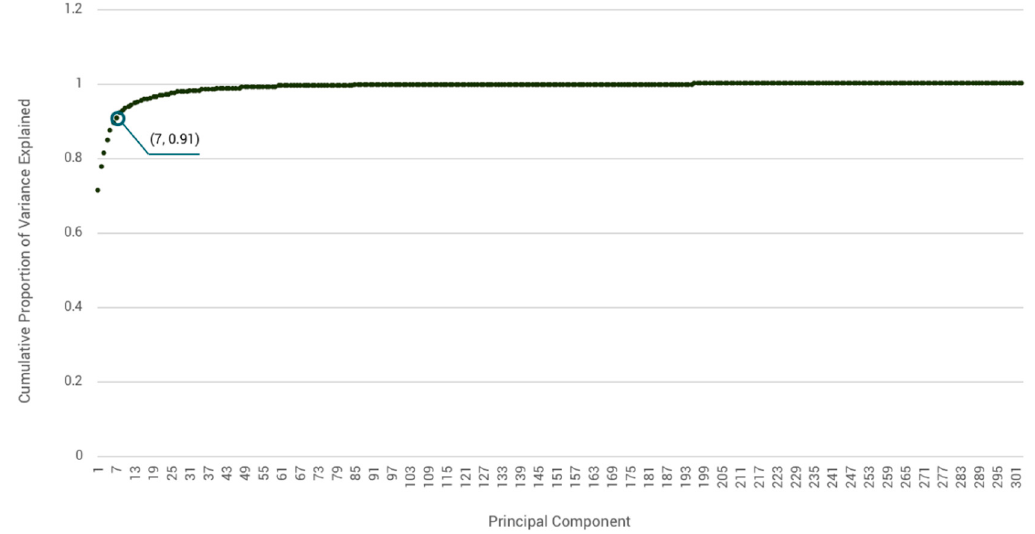
Figure 5. Plot showing the cumulative proportion of the variance explained. The first 7 PC’s explain 91% of the variance. The first PC describes the variation of the overall size of the face, changing from small to large and accounts for 72% of the total variation. The second PC is related to the width of the face, varying from narrow to wide faces. The third PC is more related to the width of the forehead and the length and angle of the chin whilst the fourth PC shows the variation of the shape of the forehead related to the shape of the jaw. The fifth component shows the variation of the shape of the jaw and the depth of the face and, for the sixth PC, the variation represents the ratio between the lower face height and the head height and variance in nasal tip protrusion. Finally, the seventh PC shows the variation in face and jaw shape and the nose and lip protrusion. The second to seventh PC respectively account for 6%, 4%, 3%, 3%, 2%, and 1% of the variability. Figure 7 shows the scatter plot of the sample along the first and second PC’s including the different shape